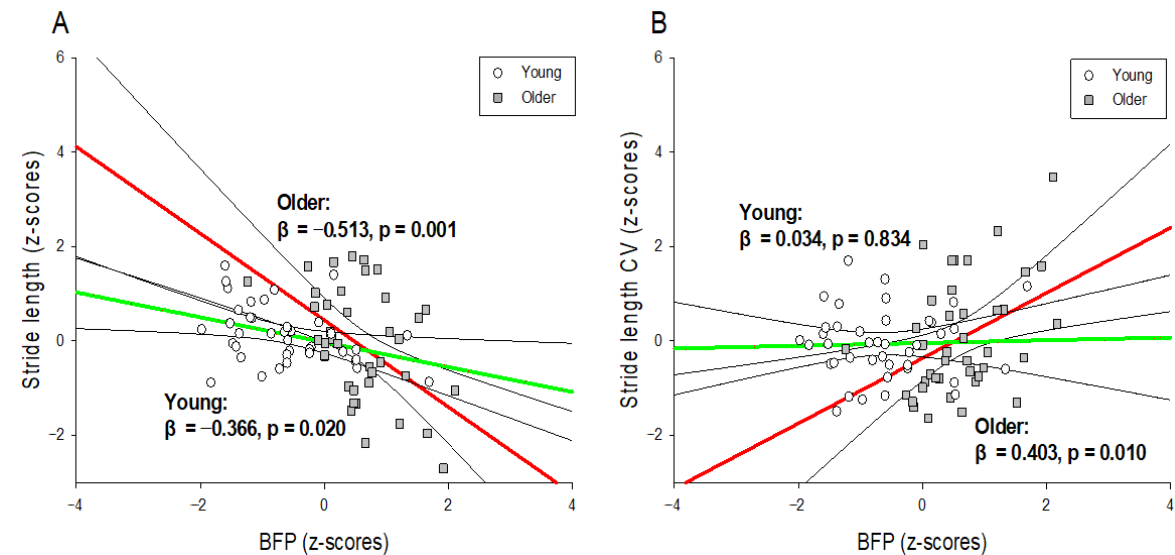
Figure 2. Interaction graphs for hierarchical moderated regression analysis. The association between normalized gait variables (( A ): gait performance and ( B ): gait variability) and normalized BFP according to age (young and older males). The linear regression line for older males is red, and that for young males is green. The black line is the 95% confidence interval of the regression line. BFP: body fat percentage; CV: coefficient of variation.